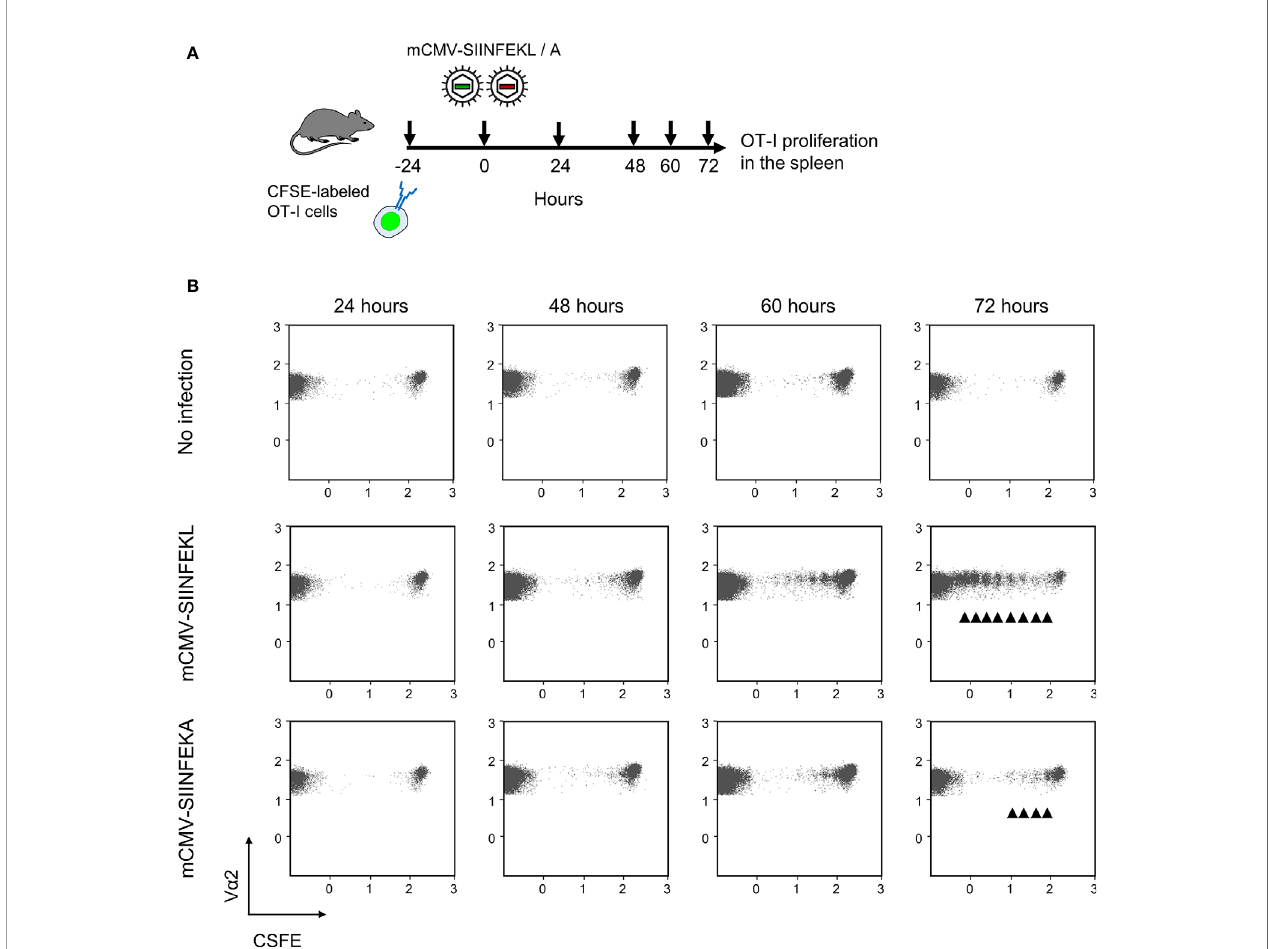
FIGURE 2 | Lymphoid-tissue homing and epitope-speci fi c proliferation of transferred OT-I cells. (A) Experimental protocol. CFSE fl uorescence-labeled OT-I cells were transferred intravenously into immunocompetent C57BL/6 mice. Proliferation of OT-I cells recovered from the spleen (from three mice pooled) was measured at the indicated times after intraplantar infection with 10 5 PFU of viruses mCMV-SIINFEKL or mCMV-SIINFEKA. (B) Cyto fl uorometric measurement of the loss of the fl uorescence label due to the proliferation of OT-I cells over time. (Ordinate), fl uorescence speci fi c for the V a 2 TCR chain expressed by OT-I cells. (Abscissa), CFSE fl uorescence. For groups of most interest, arrowheads mark cell